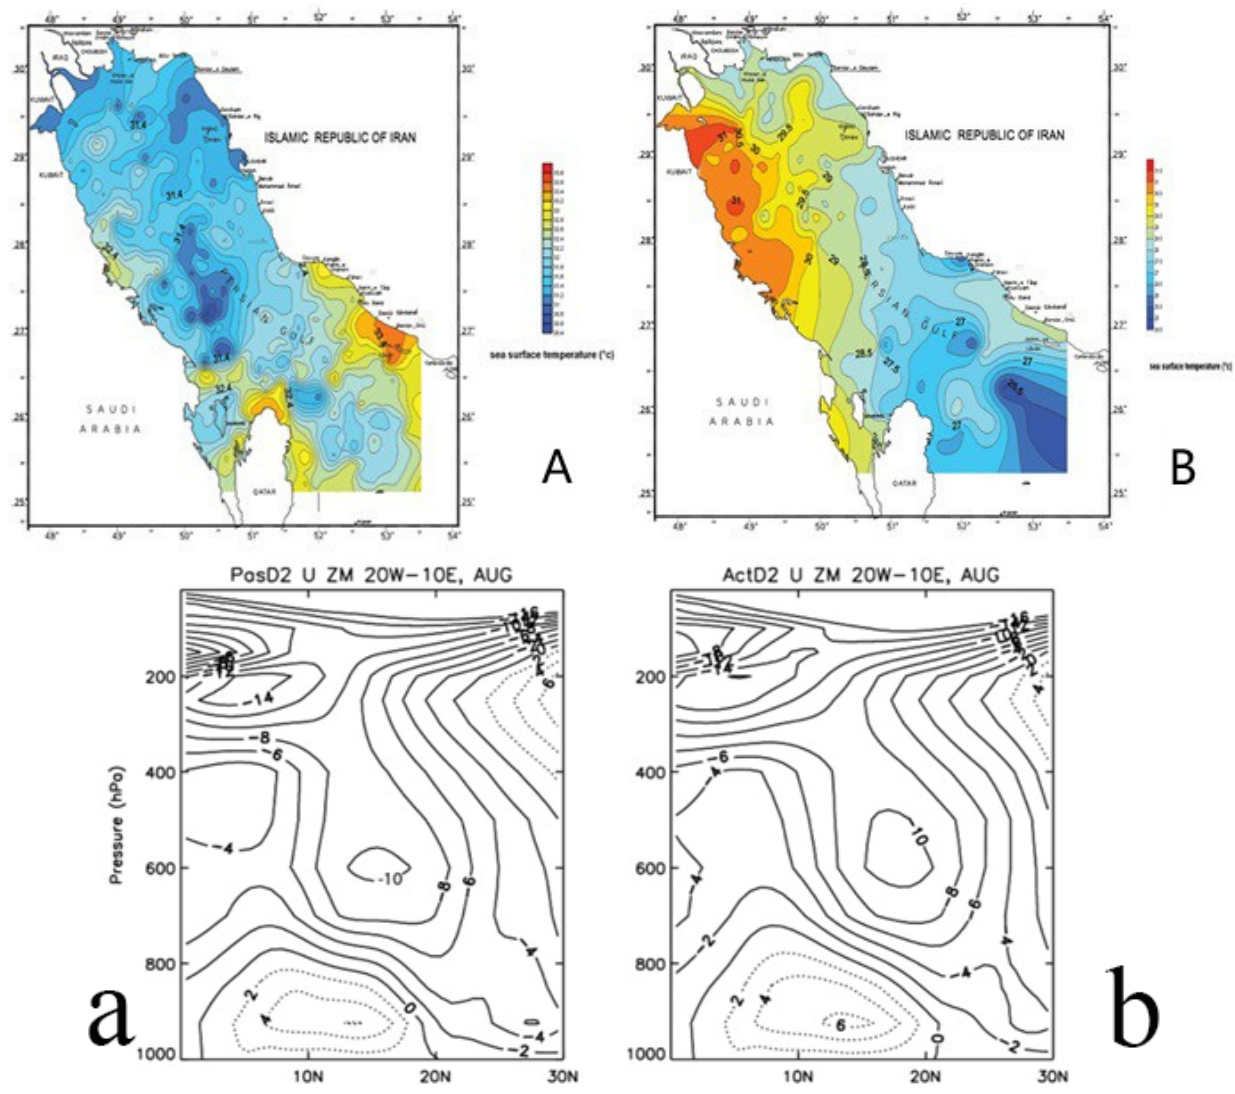
Figure 13. Surface water temperatures on August 9 in a year ( A , a ) 2008 that there was no dust and